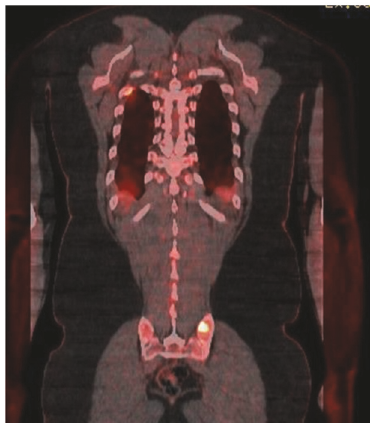
Figure 2: FDG avid lesion in left sacrum.